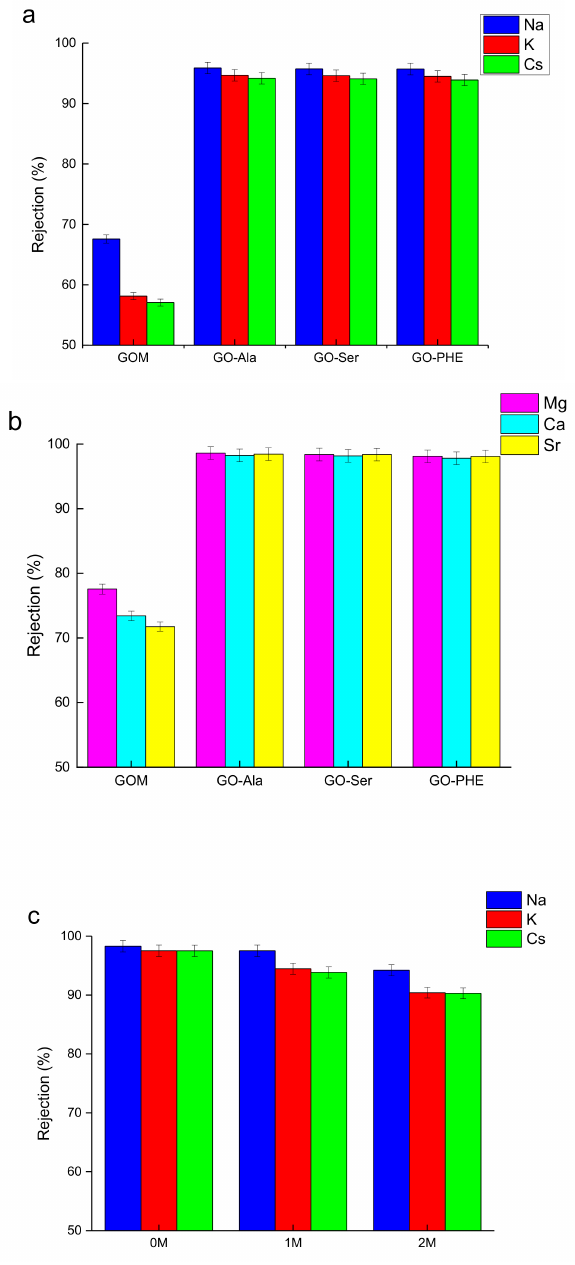
Figure 7. Rejection coe ffi cient of GO-Ala, GO-PHE, and GO-Ser to alkali metal ion ( a , b ) and e ff ect of the acidity on to alkali metal ion permeation through GO-PHE ( c ). [M] = 0.05 mol / L ( a – c ), [HNO 3 ] = 1.0 mol / L ( a , b